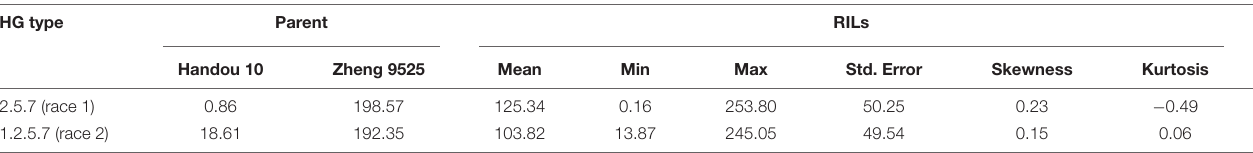
FIGURE 1 | Female index (FI) and rating distributions of SCN resistance to HG type 2.5.7 and HG type 1.2.5.7 for the RILs derived from Zheng 9525 × Handou 10, respectively. (A) The FI distribution of SCN resistance to HG types 2.5.7; (B) the rating of SCN resistance to HG types 2.5.7; (C) the FI distribution of SCN resistance to HG types 1.2.5.7; (D) the rating of SCN resistance to HG types 1.2.5.7. TABLE 2 | Descriptive statistics of the female index (FI) of the parents and the 392 F 2 : 8 RILs from Zheng 9525 × Handou10 after inoculation of SCN HG types 2.5.7 (race 1) and 1.2.5.7 (race 2), respectively.